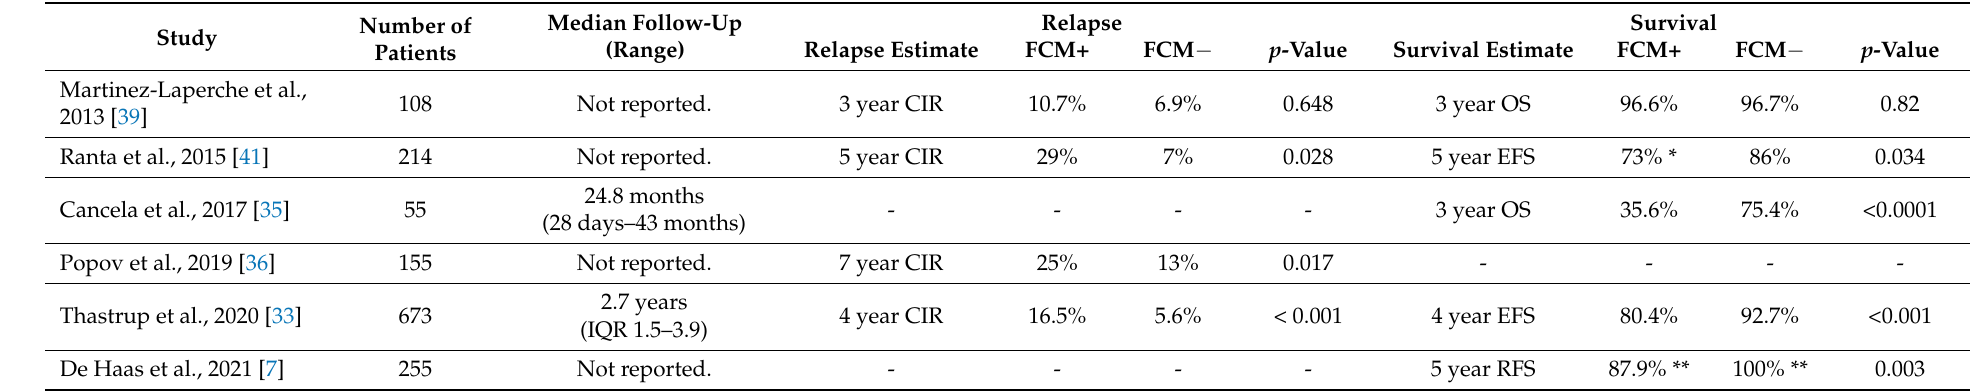
Table 3. Prognostic significance of leukemic cells detected via CSF flow cytometry at initial diagnosis in childhood ALL studies. Only studies reporting estimates of cumulative incidences of relapse or survival rates are included in the table. Reported patient numbers specify newly diagnosed patients included in the study. * Data from FCM+ and/or CM+ patients. ** Data from CNS2 patients. FCM: flow cytometry; CIR: cumulative incidence of relapse; OS: overall survival; EFS: